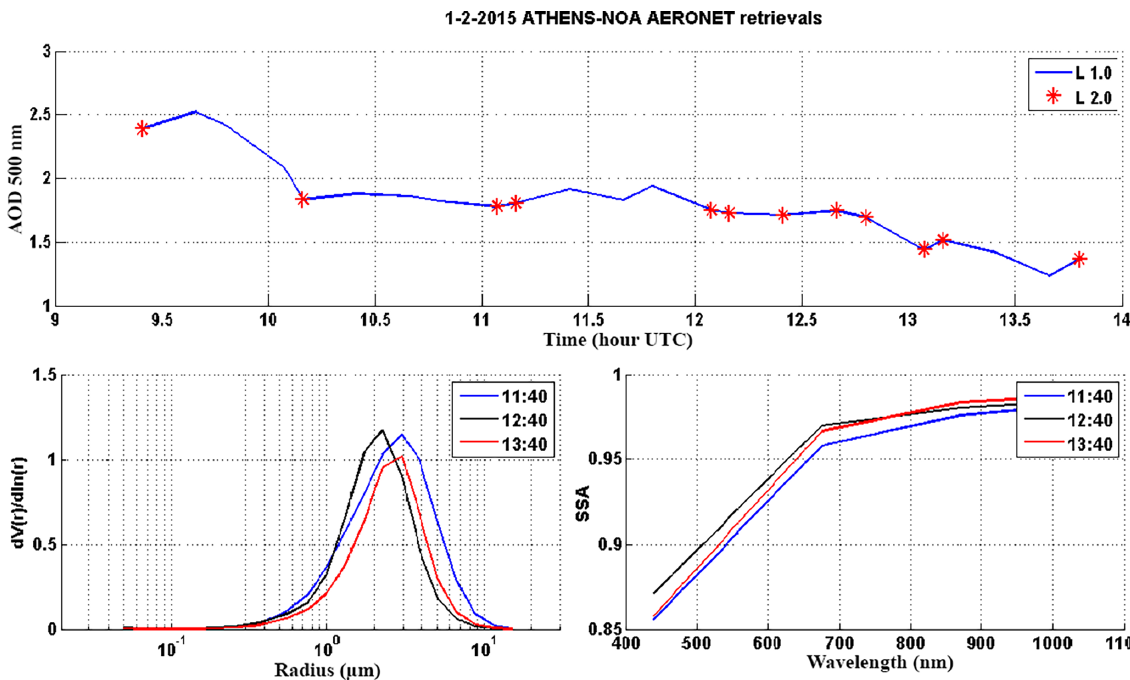
Figure 5. Temporal evolution of the AOD at 500nm obtained from the level 1.0 and 2.0 inversion algorithm of the CIMEL sun photometer at the Athens site during the day of peak dust incursion over the region on 1 February 2015 (upper) together with aerosol volume size distribution (lower left) and the spectral SSA (lower right) retrieved from the level 1.5 inversion algorithm on the same